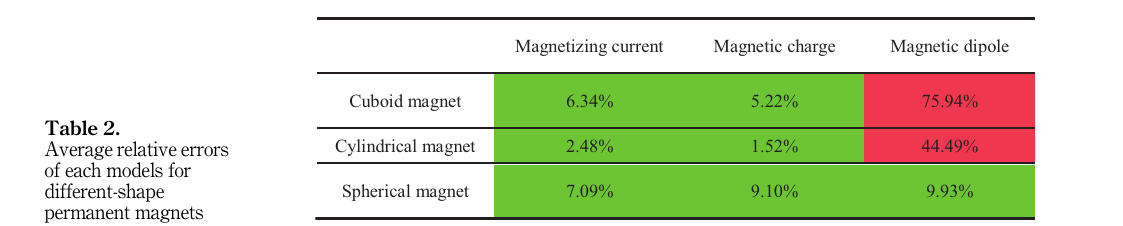
Table 2. Average relative errors of each models for different-shape permanent